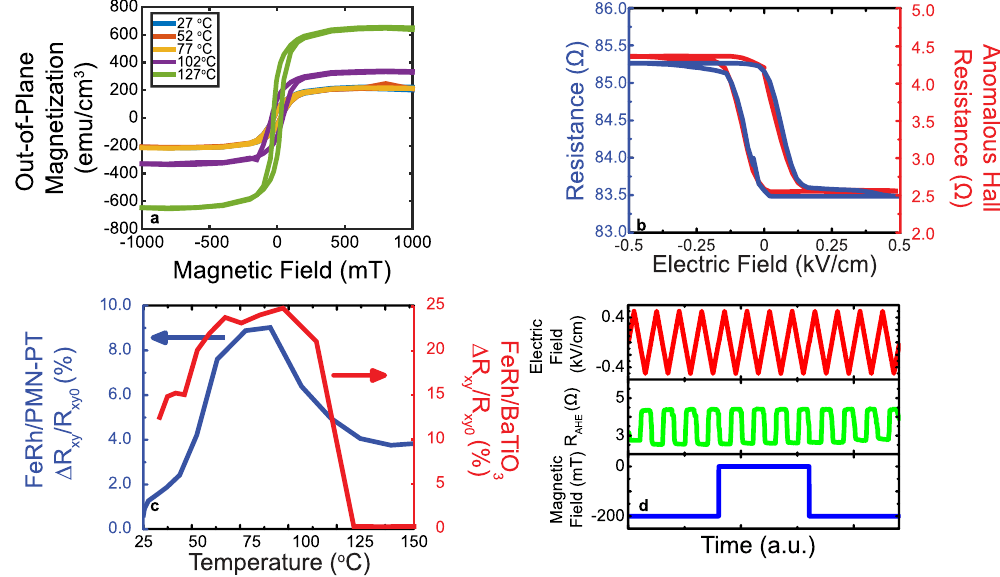
Figure 4. ( a ) Temperature dependence of the magnetic hysteresis; ( b ) normal and anomalous Hall resistance at 60 °C; ( c ) a comparison of the normalized anomalous Hall resistance for FeRh films grown on PMNPT and BaTiO 3 substrates; ( d ) demonstration of the robustness of the “protected” state to external magnetic fields.